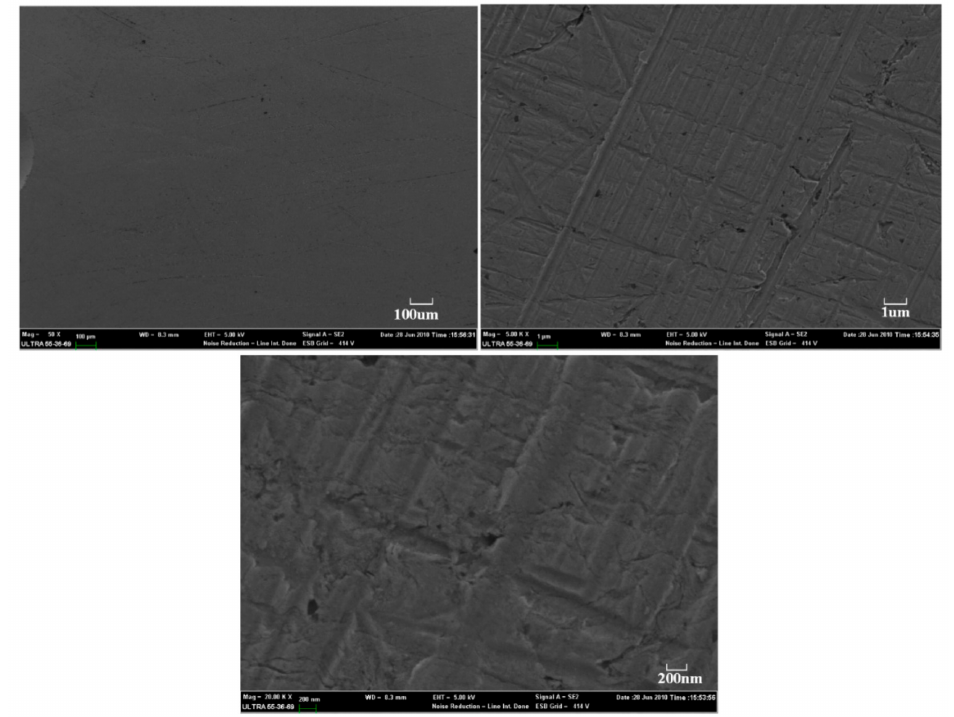
Figure 4. Image of electrodeposited film